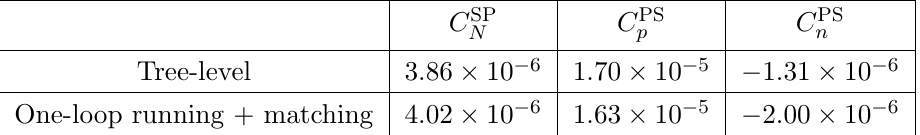
Table 1 . The values of C SP , C PS , and C PS at hadronic scale (cid:22) = 1 GeV with and without taking p n N into account the QCD running and matching e(cid:11)ects, with N = p; n . Here we take C g = 1 for the SP case and ~ C g = 1 for the PS